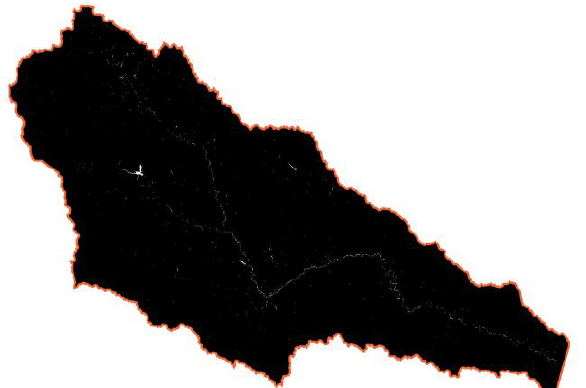
Figure 8. MST-NDWI water extraction map of the entire experimental data of Yanhe watershed